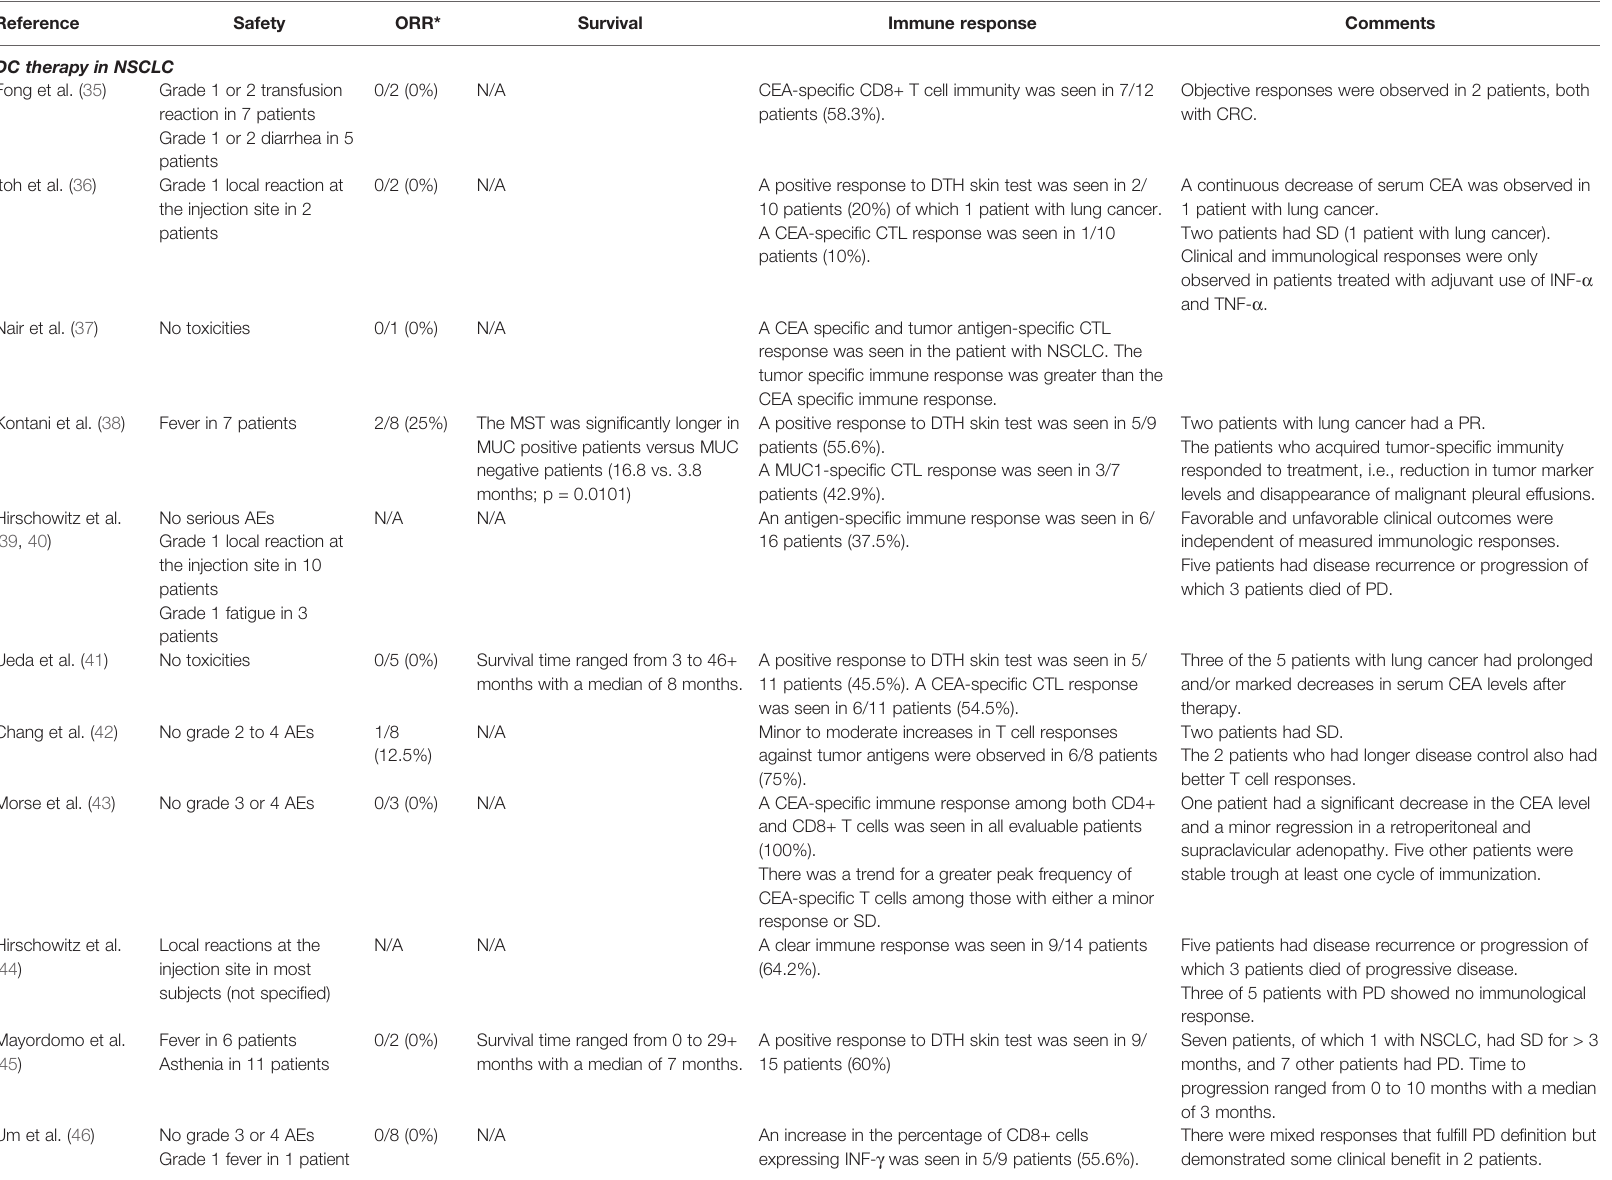
TABLE 2 | Clinical and immunological outcomes of dendritic cell (DC)-based immunotherapy in lung